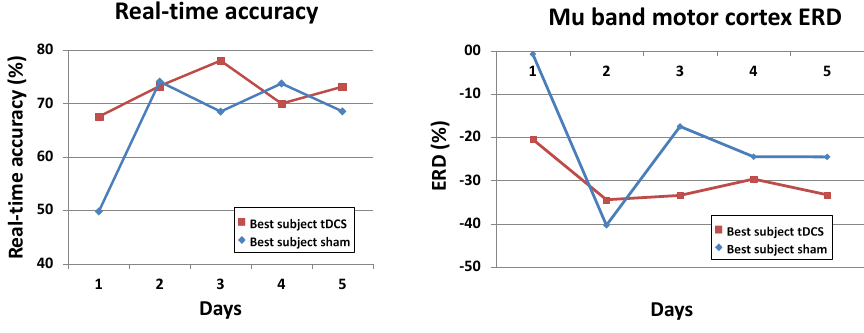
Figure 5. Real-time accuracy and ERD of the best subjects in each